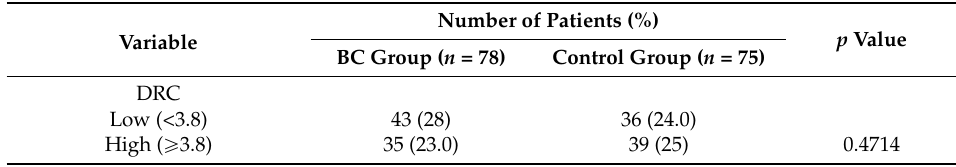
Table 1. Patient demographics of control and breast cancer patient